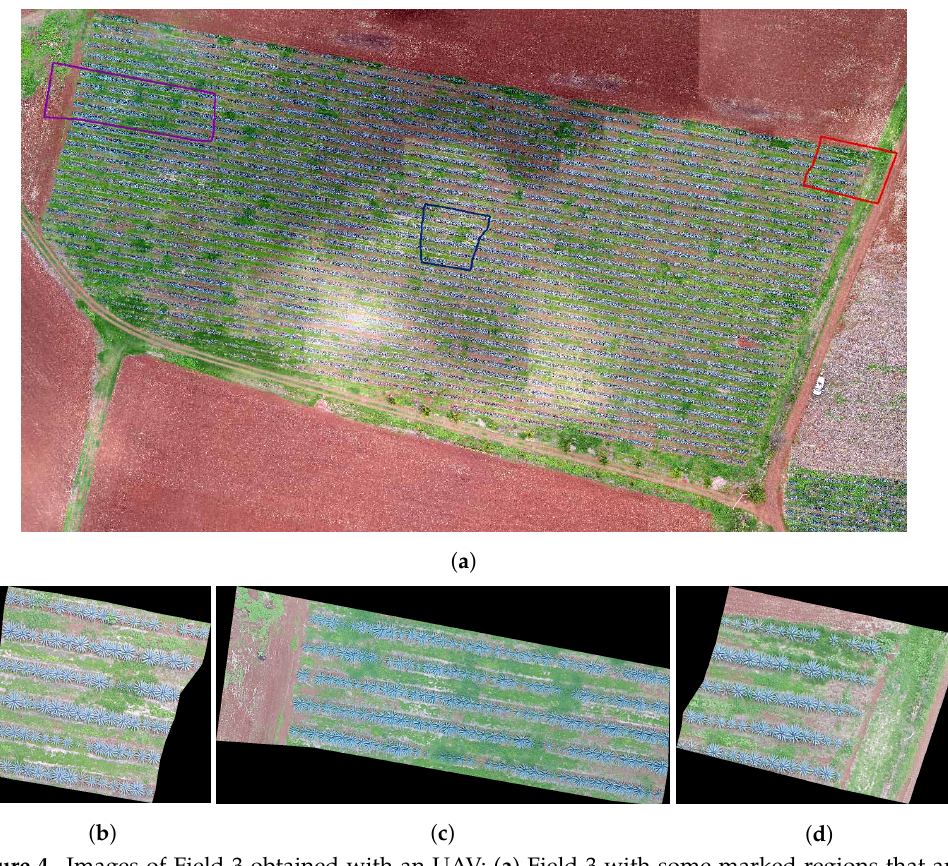
Figure 4. Images of Field 3 obtained with an UAV: ( a ) Field 3 with some marked regions that are studied in this work, ( b ) the region in blue, ( c ) the region in purple, and ( d ) the region in red.